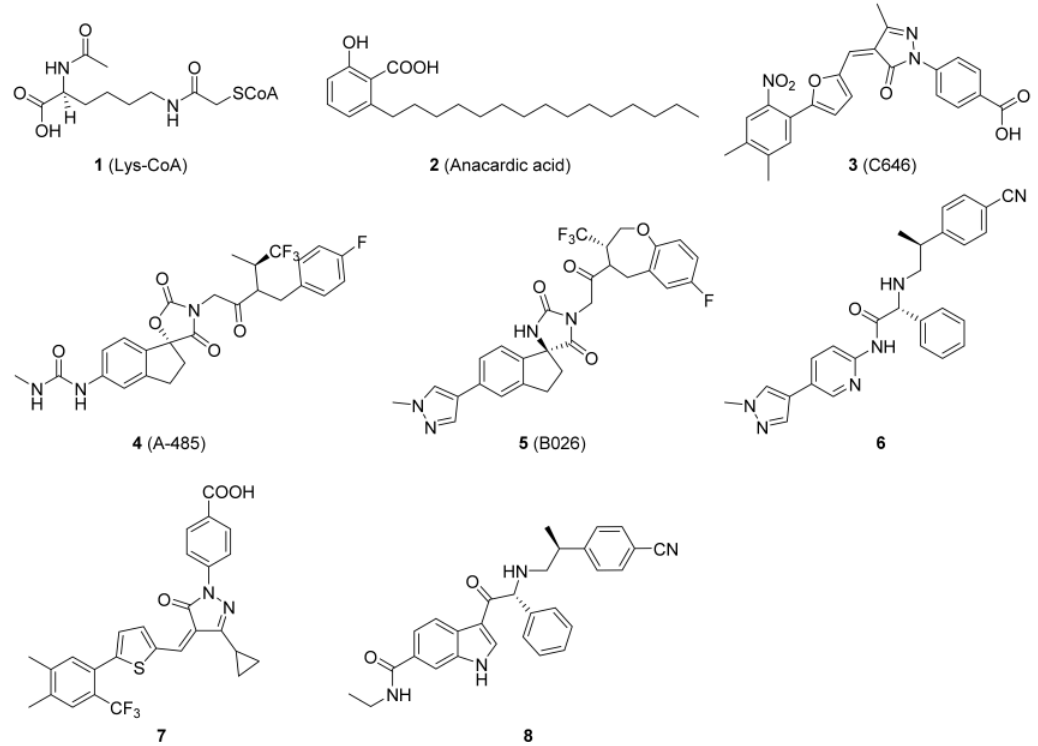
Figure 1. Representative small-molecule p300/CBP HAT inhibitors 1 – 8 . A-485 represents a significant breakthrough, but the cell potency still requires improve- ment. To better understand the binding mode of A485 and HAT domain, molecular dynam- ics studies were performed. To evaluate the quantitative contribution energy of the residues in the complex, the most practical MM-PBSA (GBSA) methods are employed [32–34]. The RMSD value of the protein backbone was calculated in a trajectory from 0 to 100 ns. As shown in Figure 2A, dynamic equilibrium was attained after approximately 40 ns of sim- ulation. The protein-ligand complex was converged to approximately 1.8 Å. Based on the relatively stable conformation, the two N atoms of methylurea group formed strong hydrogen bonds with Gln1455 and His1451 (Figure 2B,C). In contrast, the hydrogen bond between the carbonyl of spirocyclic lactam and Ser1400 became weaker after dynamics simulation (3.15 Å versus 2.94 Å). The 1,1,1-trifluoroisopropyl moiety was located in the lipophilic pocket formed by crucial Trp1466, together with Thr1411 and Pro1458. A large hydrophobic pocket formed by Val1401, His1451 and Pro1440 was also observed near the indenyl group. These two pockets offer sufficient imaginable space for molecular